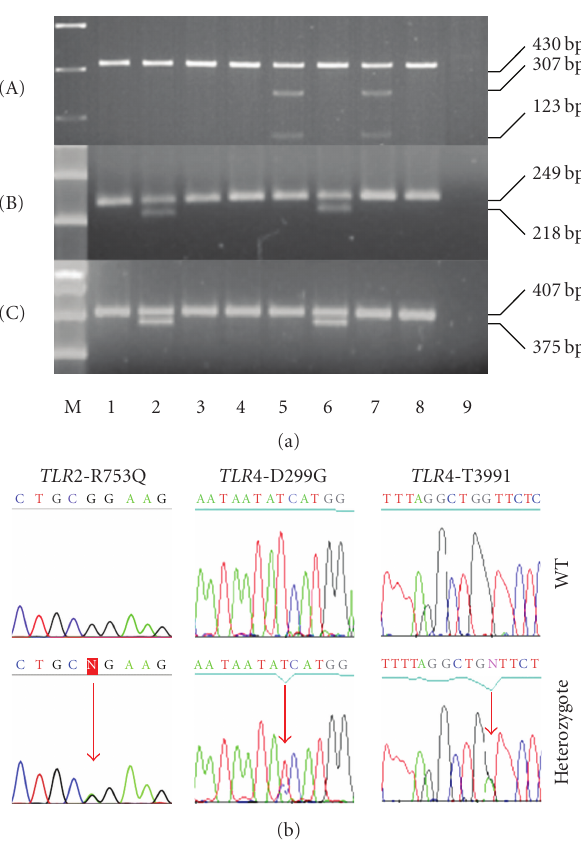
Figure 1: (a) Representative digestions showing the TLR2 -R753Q (A), TLR4 -D299G (B), and TLR4 -T399I (C) polymorphisms. M: 200bp ladder molecular weight marker. Lanes 1–8: Patients with COPD; lane 9: negative PCR control. Samples without